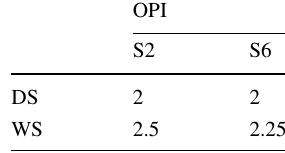
Table 12 OPI values of Shatt Al-Arab River during dry season (DS) and wet